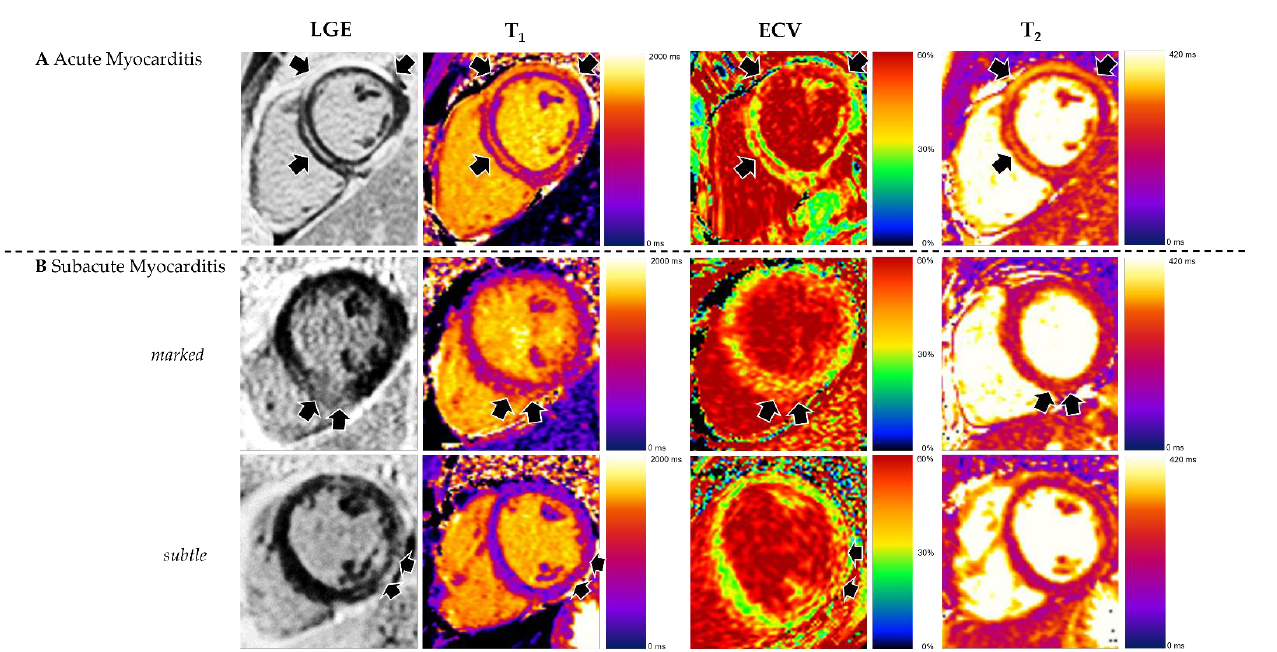
Figure 4. Appearance of Acute and Subacute Myocarditis in CMR. ( A ) Acute myocarditis often demonstrates more obvious alterations of tissue characterization parameters including high preva- lence and extent of late gadolinium enhancement (LGE) and elevated T 2 . ( B ) Subacute myocarditis can manifest with marked occurrence of LGE and elevated T 1 , ECV and T 2 ; but in many cases may demonstrate rather subtle changes in tissue characterization.